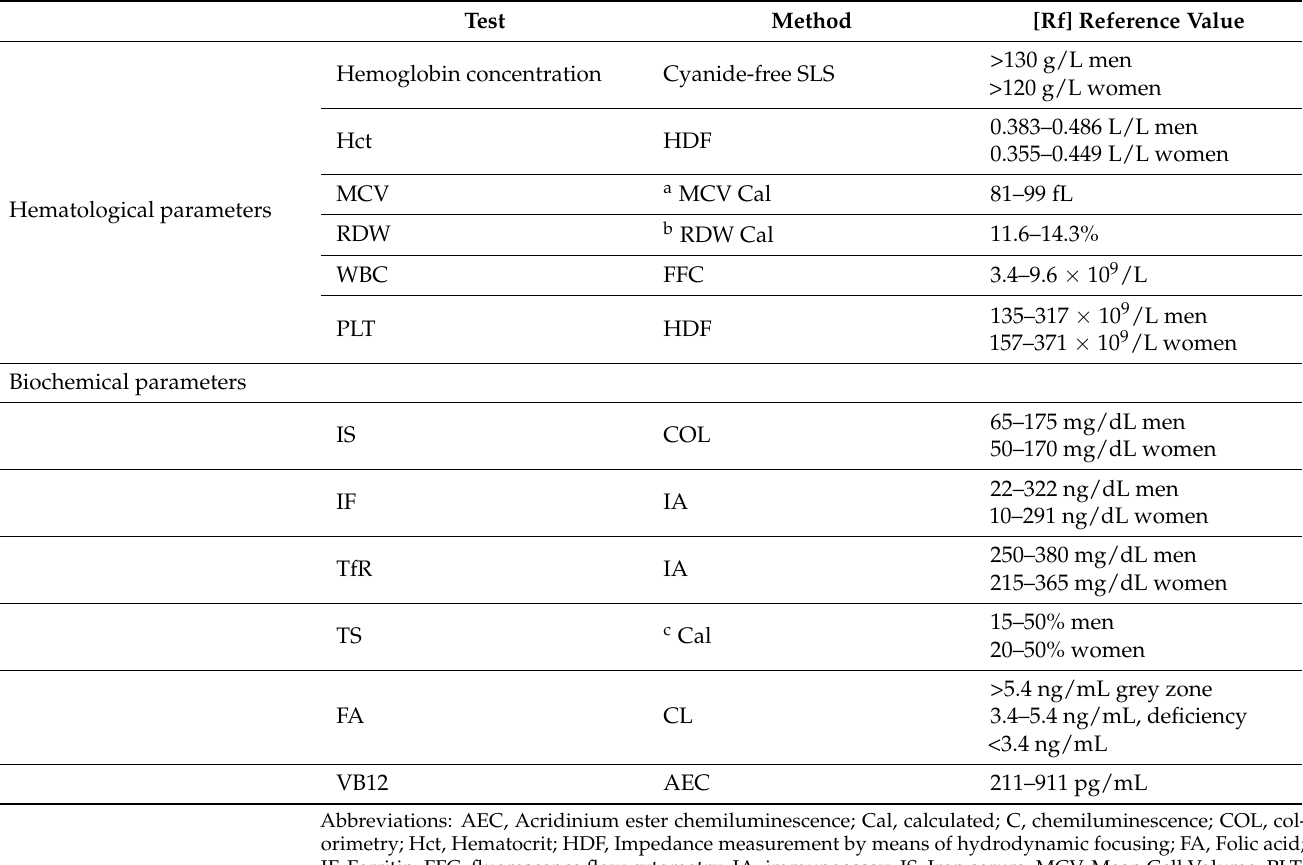
Table 1. Biochemical and hematological